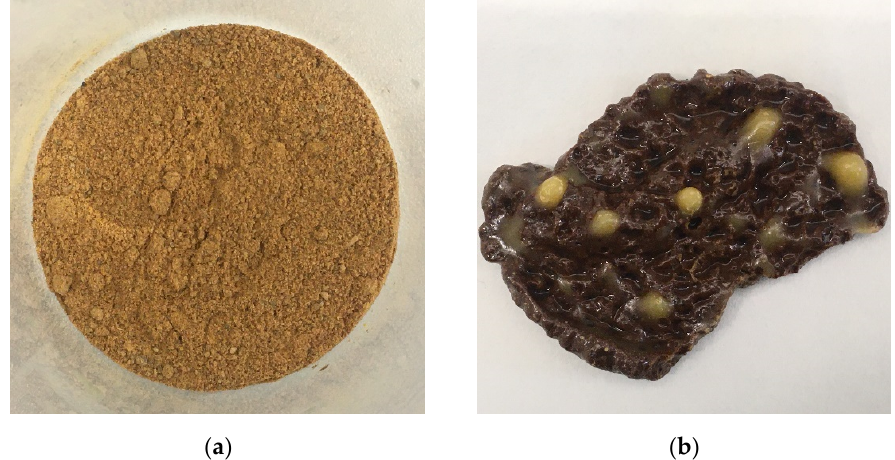
Figure 2. ( a ) Propolis before microwave-assisted extraction; ( b ) propolis after microwave-assisted extraction.